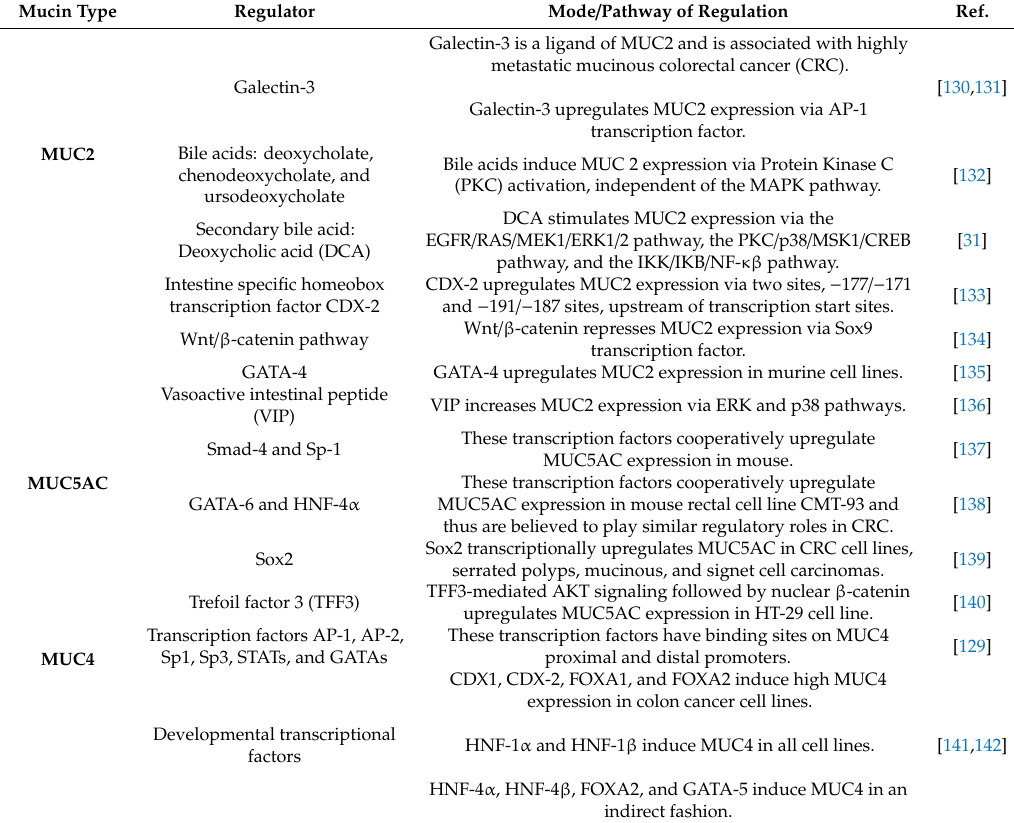
Table 2. Transcriptional regulation of secreted and transmembrane mucins of